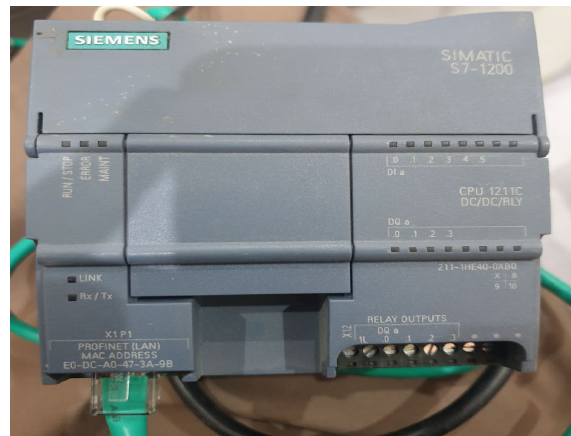
Fig. 2. PLC module used for the proposed system.